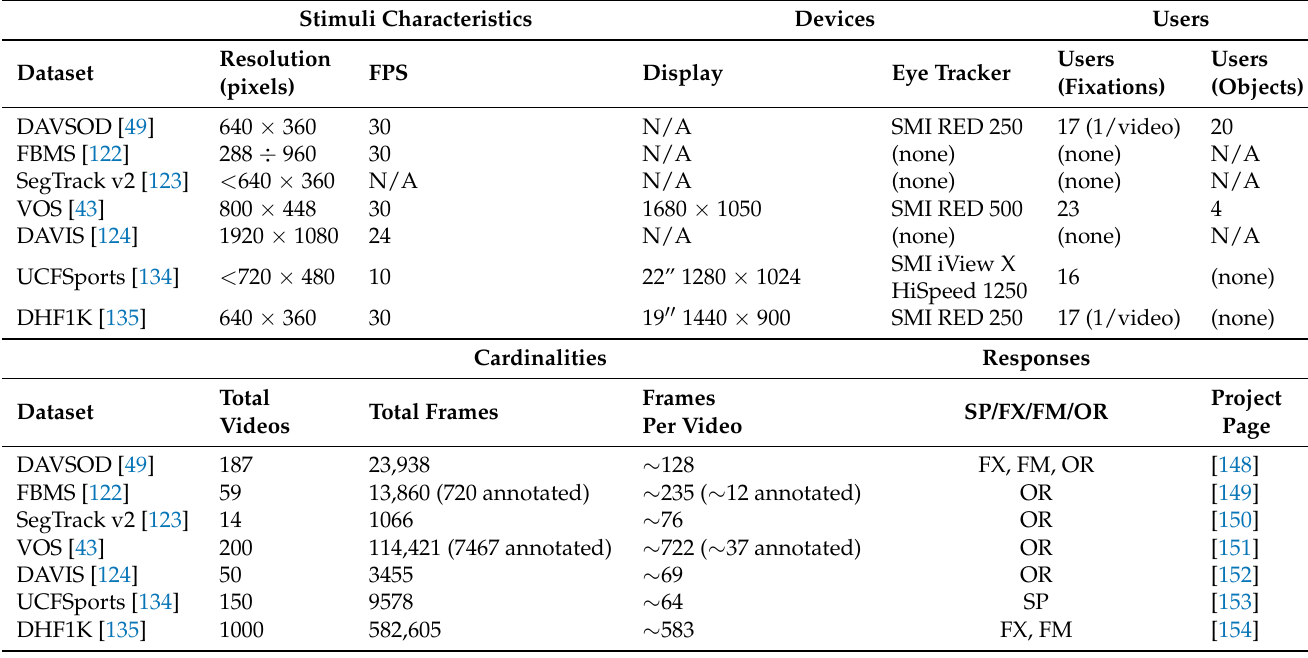
Table 11. Selected datasets for video saliency estimation, with related features (SP = Scanpaths, FX = Fixations only, FM = Fixation maps, OR = Object